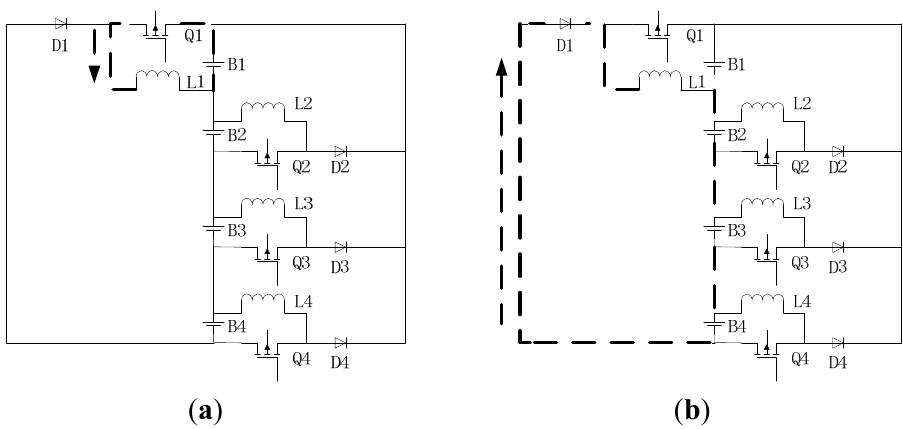
Figure 3. Current path from B